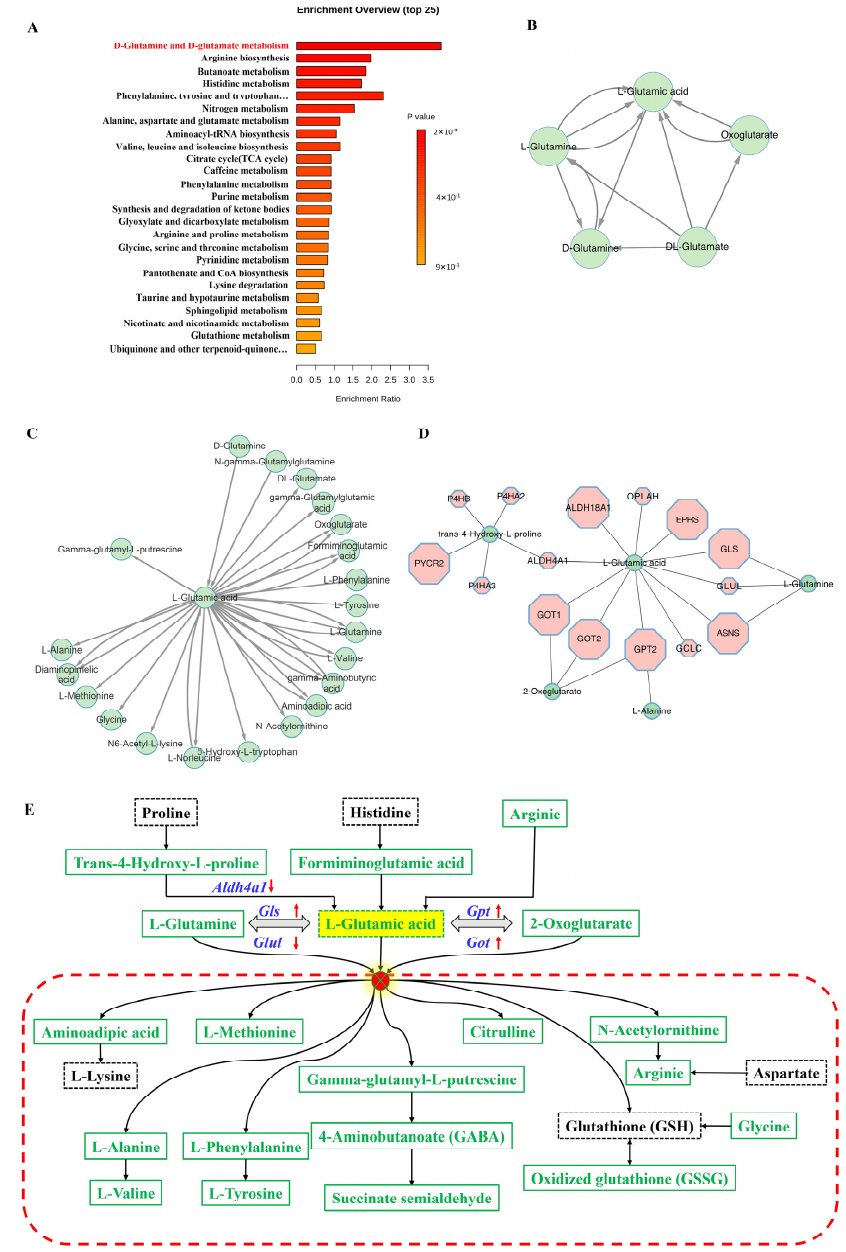
Figure 3. D-glutamine and the D-glutamate metabolism pathways and associated gene expression were affected. ( A ) Analysis of all metabolites with significant differences. The metabolism enrichment index of D-glutamine and D-glutamate metabolism was highest in metabolic activities ( p < 0.005). The higher the enrichment index, the more obviously the pathway was affected, and p < 0.05 indicated that the result was statistically significant. ( B ) Five substances in the pathway were downregulated. In the metabolite association analysis, all four metabolites were associated with the production of L-glutamic acid. ( C , D ) Map of all L-glutamic-acid-related differentiated metabolites and gene networks in metabolite association analysis ( C ) and metabolite (green circle)–gene (red hexagon) association analysis ( D ). ( E ) Pattern diagram of integrated metabolite–gene interaction network. Green indicates metabolites that are detected and also reduced, and black indicates metabolites with insignificant changes. Blue represents genes, with arrows pointing to suggest trends. Other colours without special instructions do not imply trend change. ( Aldh4a1 , aldehyde dehydrogenase family 4, member A1, Gls , glutaminase, Got , glutamic oxaloacetic transaminase, Gpt , glutamine-pyruvate transaminase, Glul , glutamate-ammonia